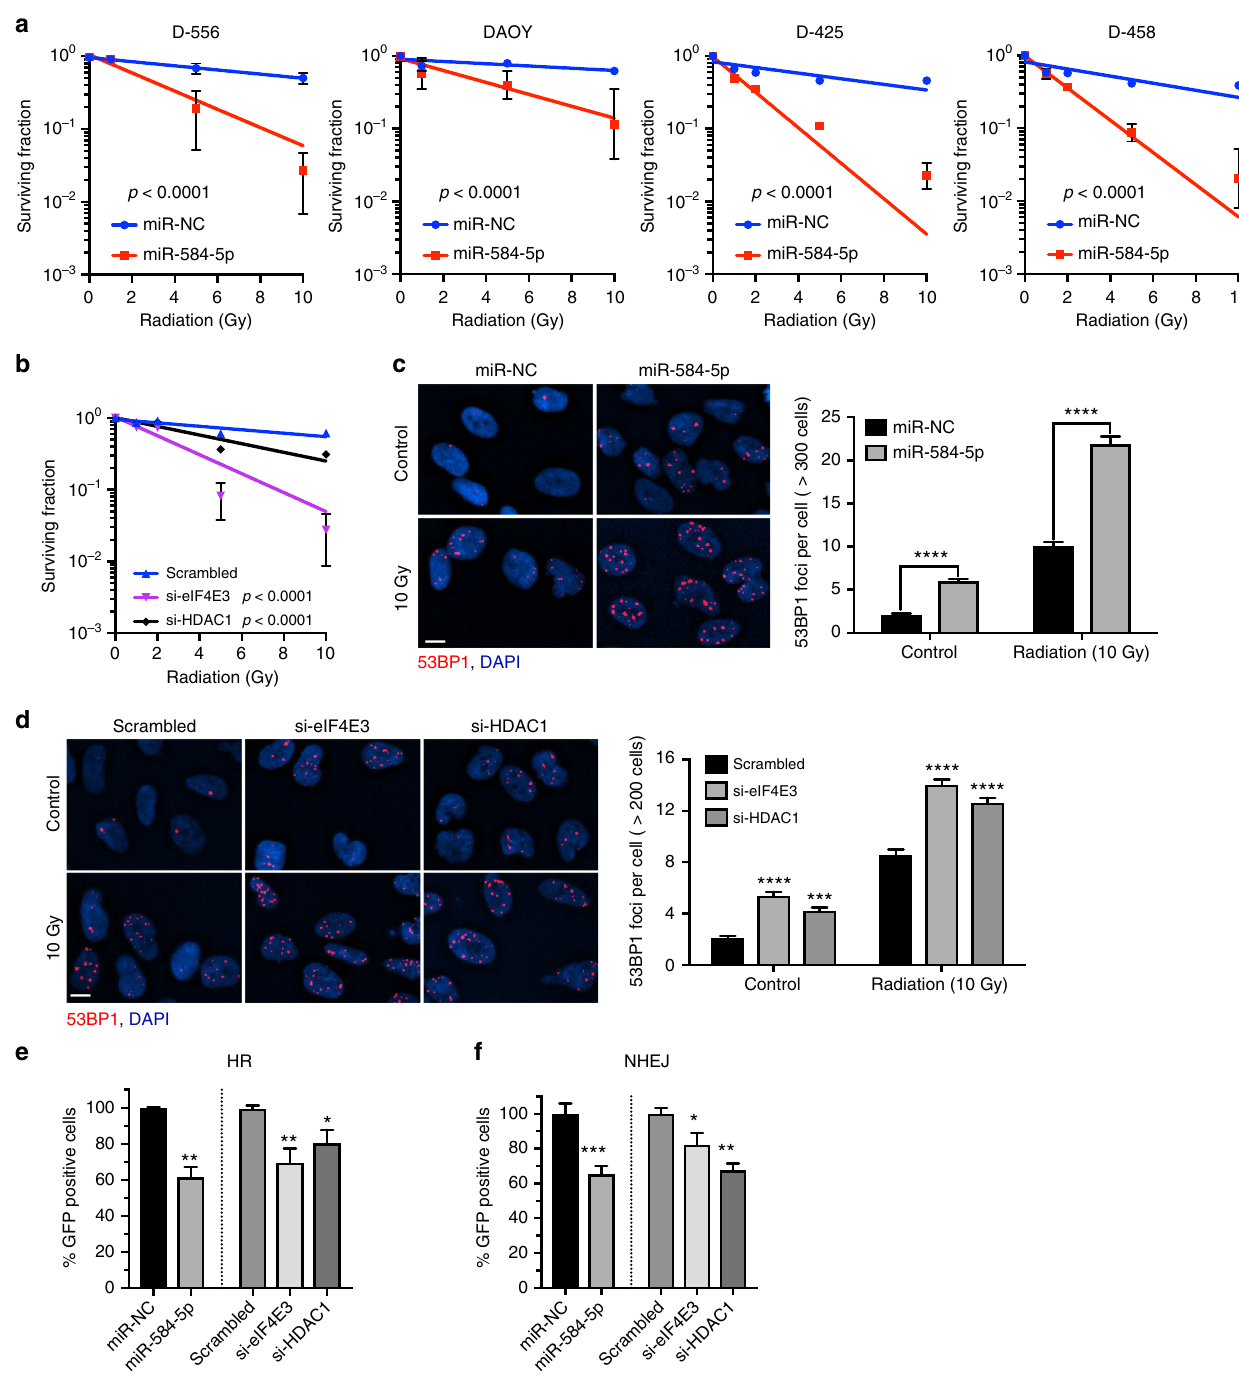
microtubule dynamics in MB. eIF4E3 and HDAC1 may affect the dynamics of microtubules by directly interacting with them.